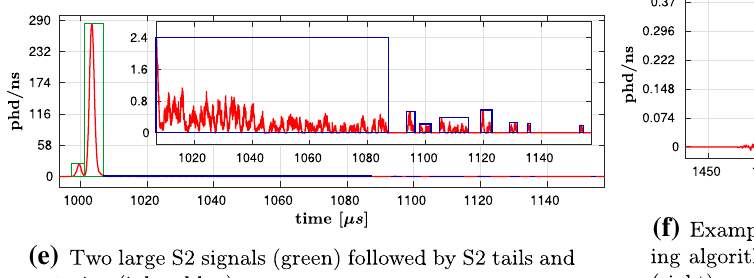
Fig. 1 Examples of typical pulses expected in dual-phase noble ele- mentTPCs,obtainedfromLZsimulateddata.Pulseamplitudesarecon- verted to units of photons detected (phd) per nanosecond. The coloured boxes represent the pulse boundaries calculated by a simple pulse find- ing algorithm, the purple and green boxes mark the main S1 and S2